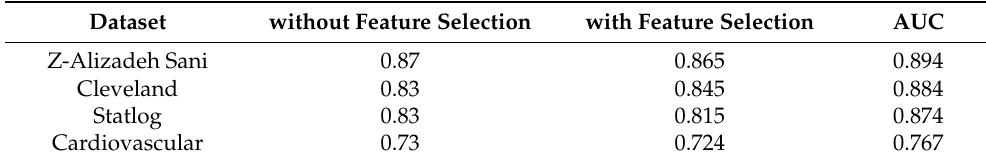
Table 7. Performance accuracy using the XGBoost classification.